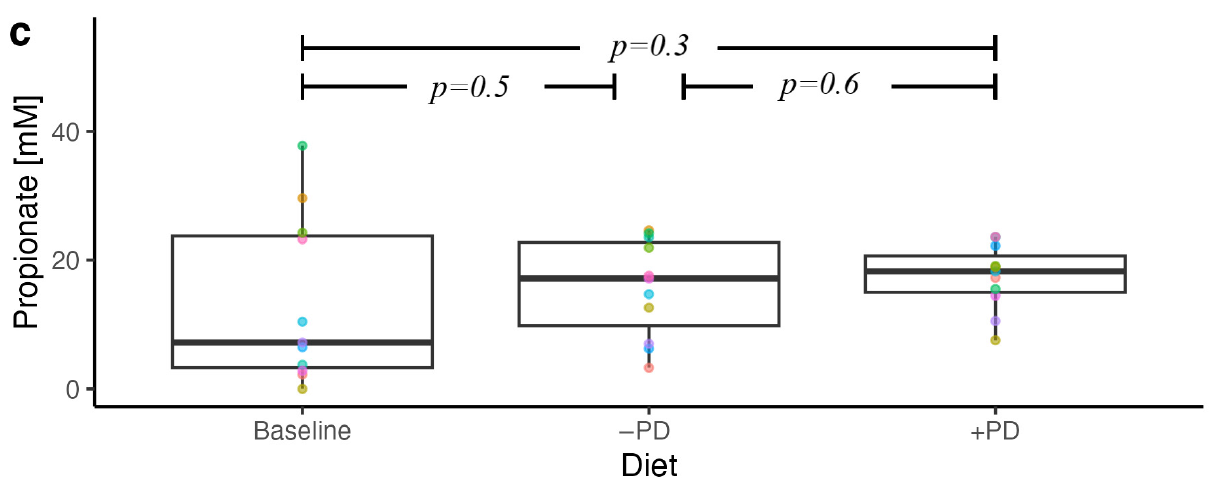
Figure 2. Faecal short chain fatty acid concentrations in privately owned healthy adult dogs (n = 11) fed a commercial diet with (+PD) or without ( − PD) Enterococcus faecium NCIMB 10415 10 9 CFU/kg for 16 days each in a crossover study design compared to baseline concentrations. Each dot colour on the plot identifies the individual dog across diets. p values < 0.05 were considered significant.